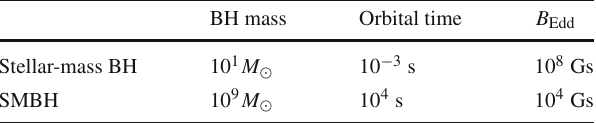
Table 1 Typical size, inISCO orbital timescale, and Eddington MF for stellar and SMBHs, representing characteristic values of many BH candidates